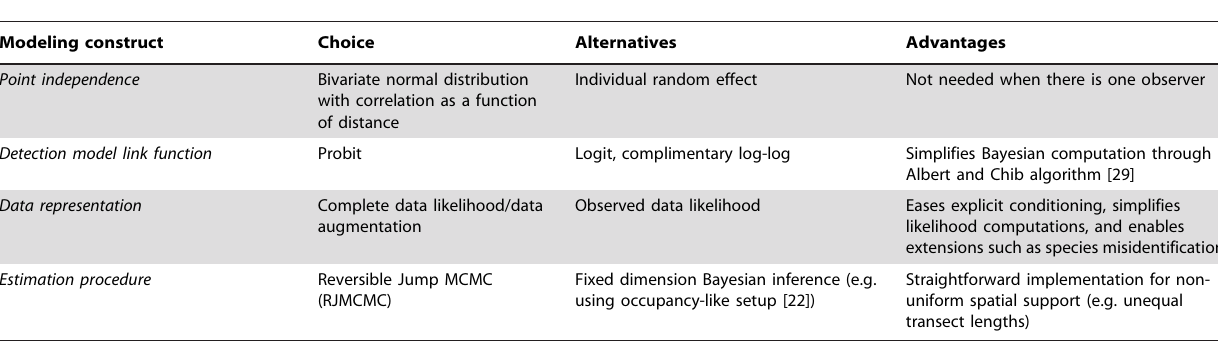
Table 2. Modeling choices and